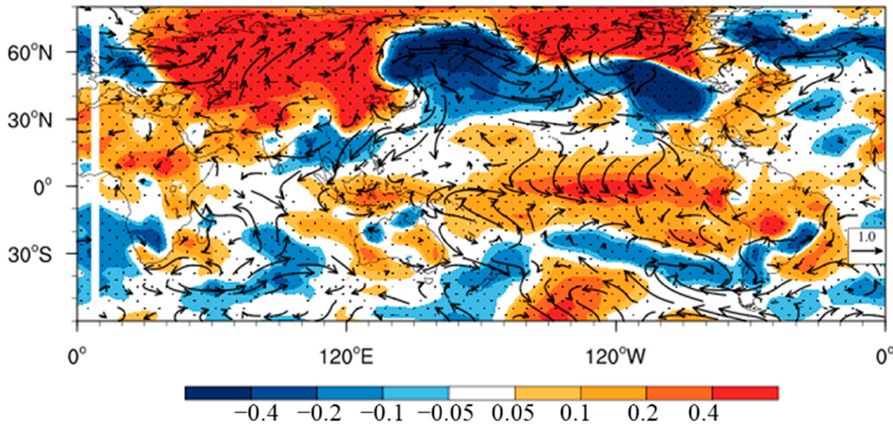
Figure 9. Regressed global t2m anomalies (shading; K) and surface wind anomalies (vector; m s − 1 ) in December onto Northeast Pacific SST anomalies in July from NESM3.0 with observed SST in the Northeast Pacific. Stippling indicates significant regressed SST anomalies at the 95% level from Student’s t -test. Black vectors are significant regressed surface wind anomalies at the 95% level from Student’s t -test.